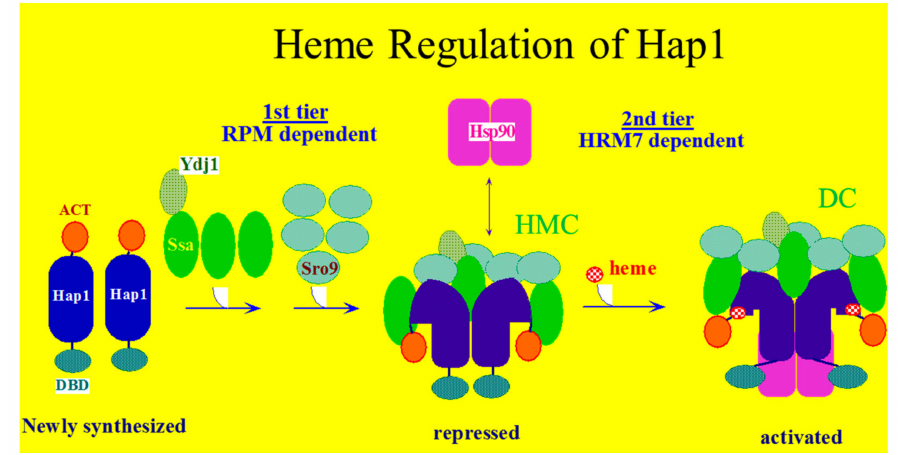
Figure 1. Hap1 repression modules (RPMs) promote Hap1 association with Ydj1, Ssa (Hsp70), and Sro9 to form an inactive High Molecular Weight Complex (HMC). Upon heme binding to Heme Responsive Motif 7 (HRM7), Hsp90 is stably bound and the HMC is disrupted, producing the active dimeric complex (DC). In the new complex, the Hap1 acidic activation domains (ACT) are activated and DNA binding is promoted via the DNA binding domains